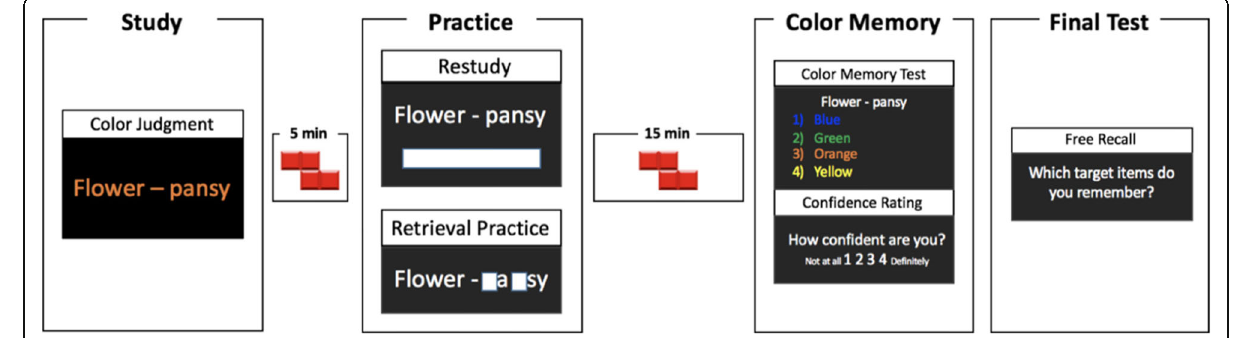
Fig. 1 A schematic depiction of the design of Experiment 1. See text for